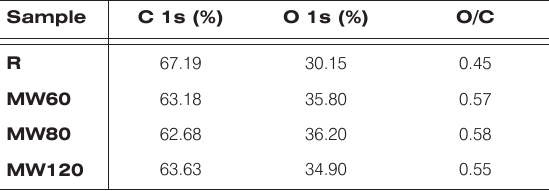
Table 3. Percent values of C1s, O1s and oxygen/carbon atomic ratio. Sample